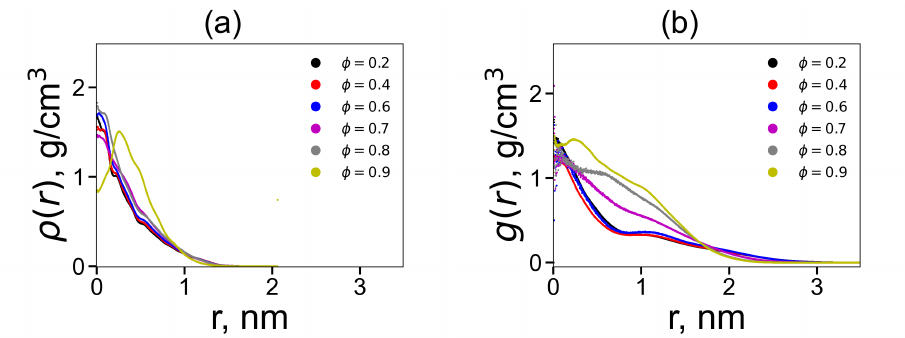
Figure 5. The radial distribution function of density ρ ( r ) as a function of distance r from the center of mass of the dendrigraft at different methanol fractions φ : ( a ) DGL1, ( b )